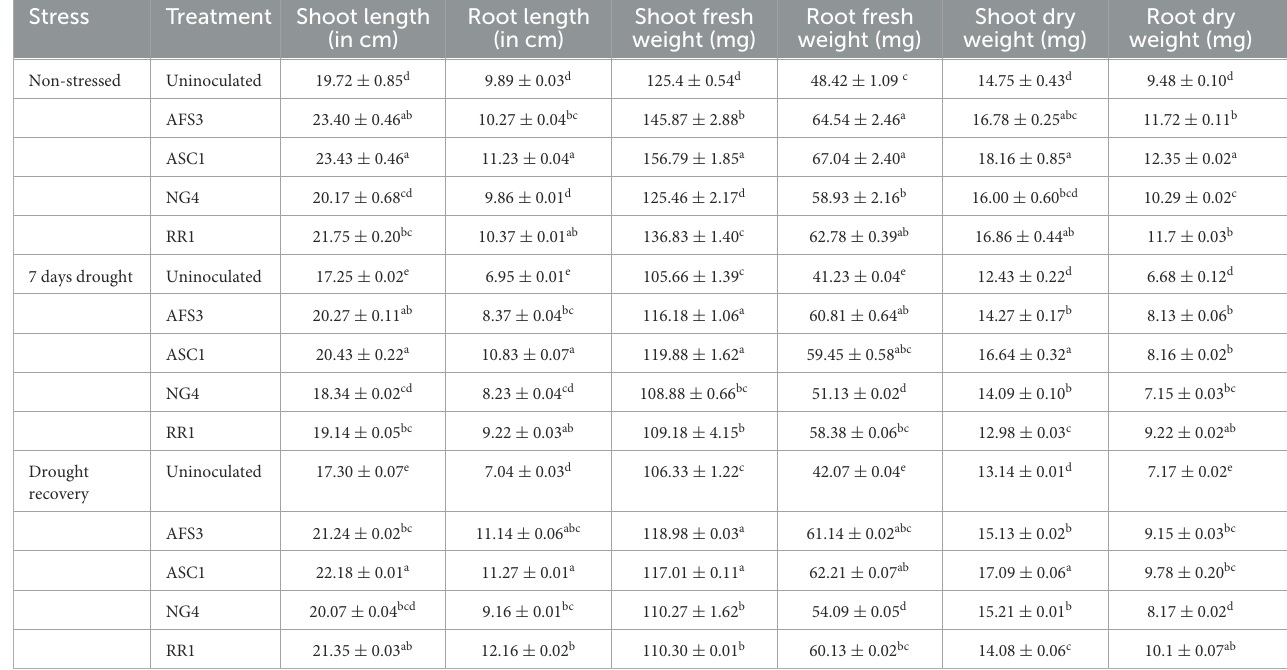
TABLE 3 Effects of bacterial treatments on root and shoot length and fresh, and dry weight of root and shoot of wheat under non-stress conditions, drought conditions, and during drought recovery under pot trial conditions.